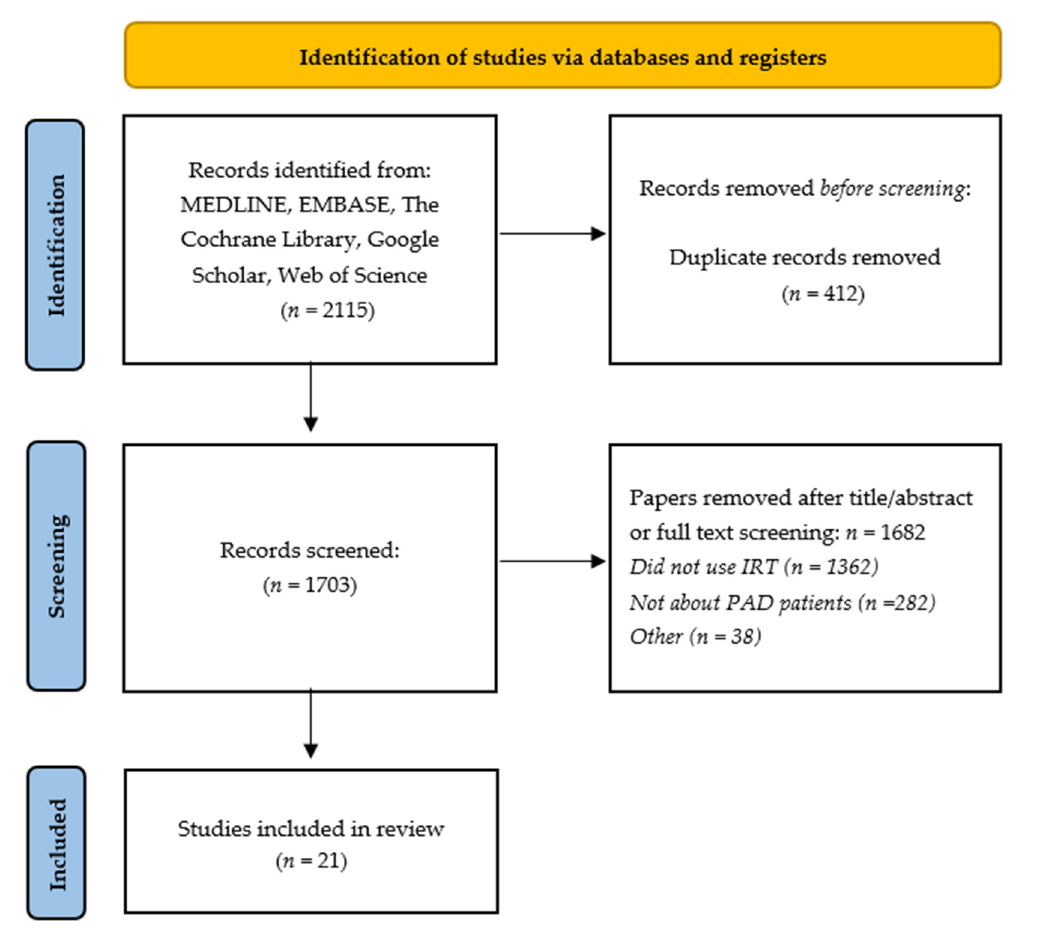
Figure 1. Study flow diagram (PRISMA 2009).